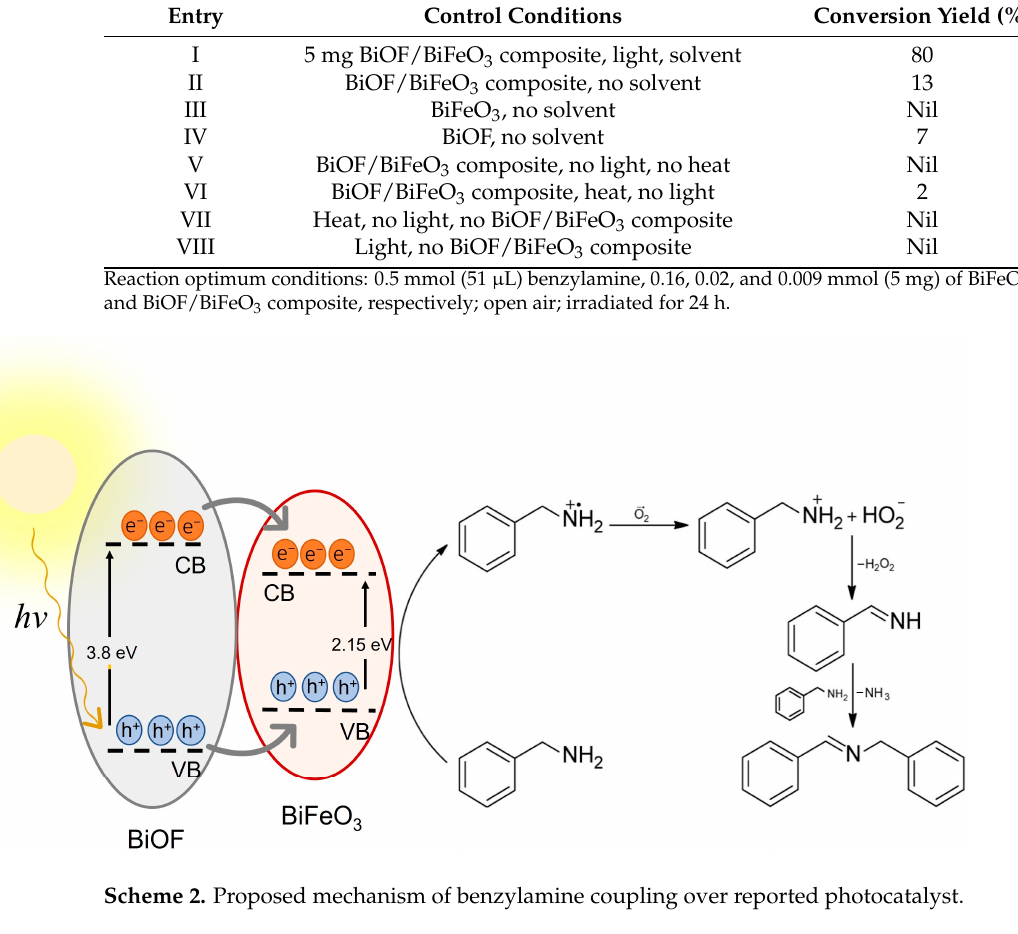
Table S1: Weight and atomic percentages of BiOF; Table S2: Weight and atomic percentages of BiOF; Table S2: Weight and atomic percentages of BiFeO 3 ; Table S3: Weight and atomic percentages BiFeO 3 ; Table S3: Weight and atomic percentages of BiOF/ BiFeO 3 composite; Figure S6: Spectra of N -benzylidenebenzylamine product using 1 H-NMR (A) and 13 C-NMR (B); Figure S7: FTIR spectrum of N